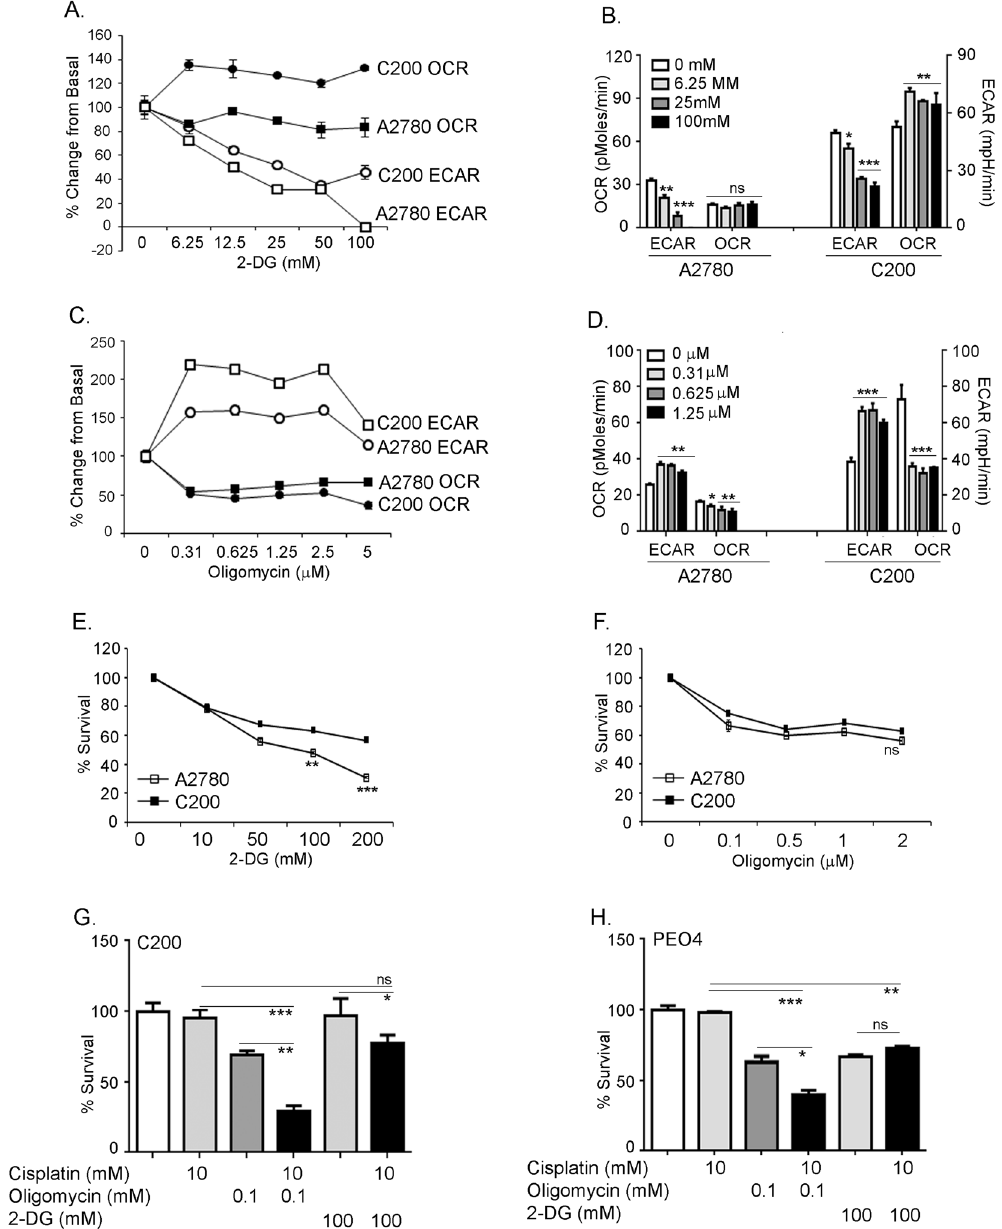
Figure 6. Resistant ovarian cancer C200 cells have the ability to switch between energy states. ( A ) Equal number of cells were plated in multi-well Seahorse Biosciences XF96 plate (Boston, MA), and after calibration time indicated doses of 2-deoxyglucose (2DG) were injected and measurements of OCR and ECAR were recorded in triplicates. ( B ) Bar graph representation of the dose-dependent effect on ECAR and OCR after 2DG inhibition of glycolysis. *** p < 0.001, ** p < 0.01, * p < 0.05 2DG treated compared to untreated. ( C ) Equal number of cells were plated in multi-well Seahorse Biosciences XF96 plate, and after calibration time indicated doses of oligomycin were injected and measurements of OCR and ECAR were recorded in triplicates. ( D ) Bar graph representation of the dose-dependent effect on ECAR and OCR after oligomycin inhibition of mitochondrial function. *** p < 0.001, ** p < 0.01, * p < 0.05 oligomycin treated compared to untreated. All Seahorse experiments were performed in triplicates and replicated twice. A2780 and C200 were plated at 4000 cells per well in 96 wells and treated with indicated concentrations of ( E ) 2DG or ( F ) oligomycin and live cells were measured at 48 h using Promega Cell Viability Assay. The data is represented as percent survival compared to untreated control cells, which were taken as 100% live cells. ** p < 0.01, * p < 0.05 C200 compared to A2780. The experiment was performed in triplicates thrice. Chemoresistant C200 ( G ) and PEO4 ( H ) cells were treated with cisplatin in the presence or absence of 2DG or oligomycin and live cells were measured at 48 h using Promega Cell Viability Assay. The data is represented as percent survival compared to untreated control cells, which were taken as 100% live cells. The cell survival studies were carried out in triplicates and replicated thrice. *** p < 0.001, ** p < 0.01, * p < 0.05 combination compared to individual